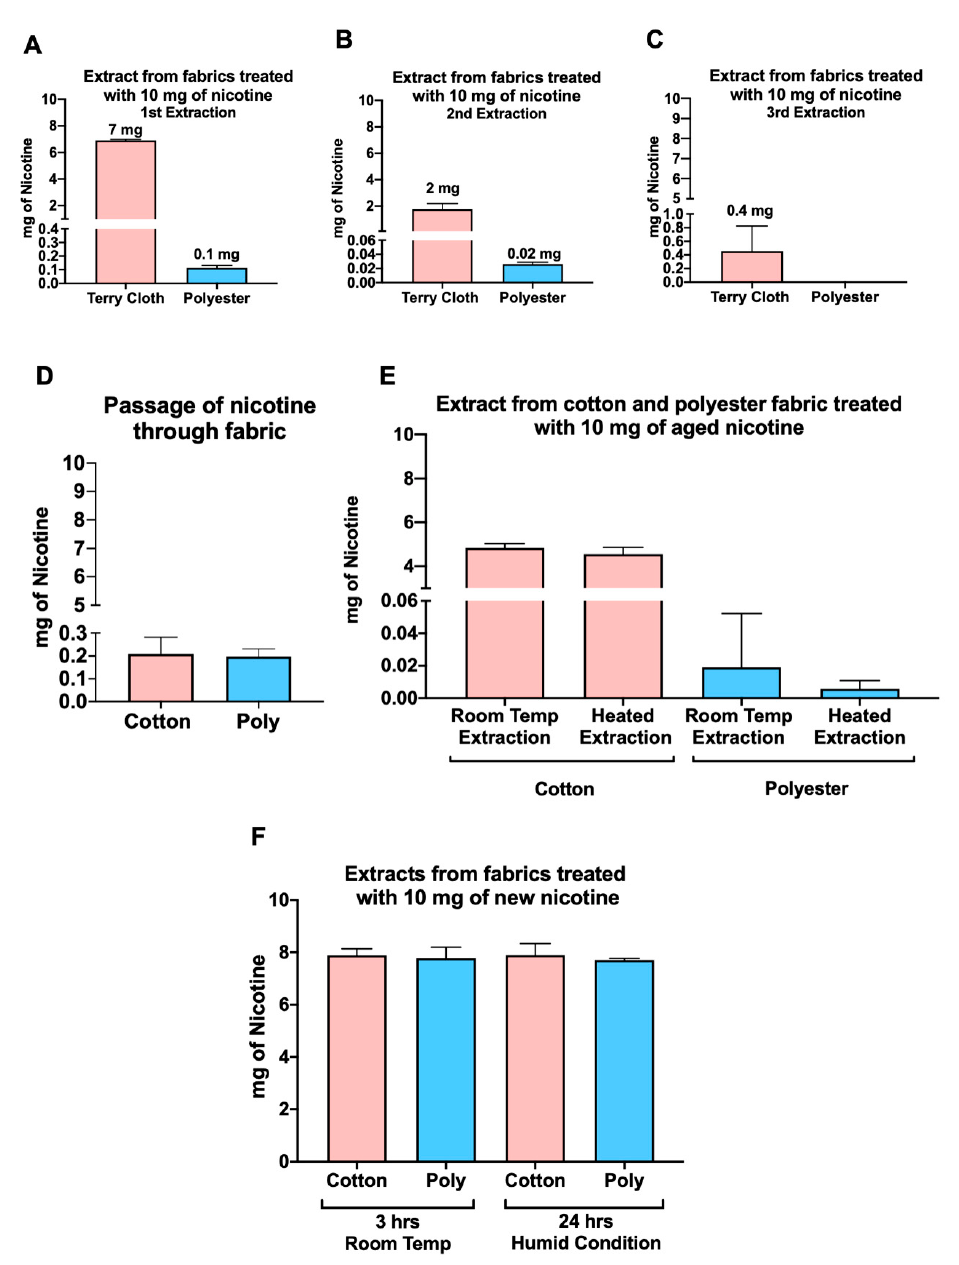
Figure 5. Nicotine extraction was more efficient from polyester when fabrics were exposed in humid conditions. Nicotine was measured using HPLC. Ten milligrams of nicotine was placed on cotton or polyester, and nicotine was extracted in water 24 h later. ( A – C ) Most of the nicotine (7 of 10 mg) was recovered in the first extract of terry cloth, while only 0.11 mg was recovered from polyester. ( D ) Nicotine did not filter through either of the fabrics. ( E ) Heating did not improve the release of nicotine from cotton or polyester. ( F ) About 80% of the nicotine was recovered from both cotton and polyester when exposure was done for 3 h at room temperature or for 24 h in humid conditions.